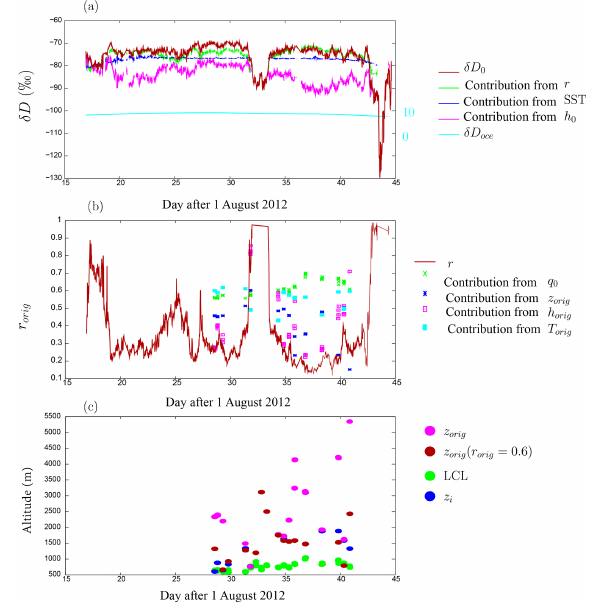
Figure 13. (a) Time series of δD 0 observed during the STRASSE cruise, together with its four contributions. The δD of the surface ocean water is also plotted with the scale on the right. (b) Time series of r orig estimated from observations during the STRASSE campaign, together with its four contributions. (c) Times series of z orig , z orig (r orig = 0 . 6 ) , LCL, and z i estimated from the STRASSE